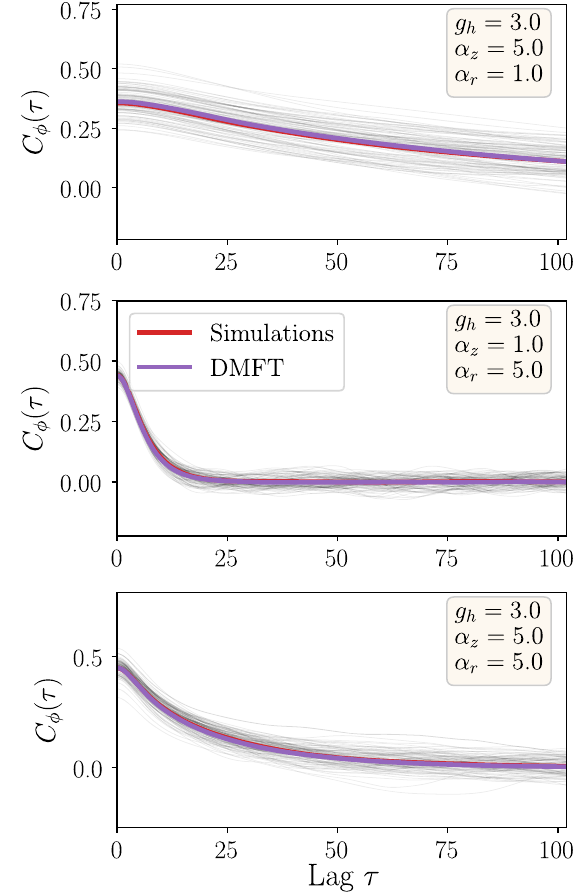
FIG. 9. Validating the DMFT. We show the comparison between the population-averaged correlation functions C ϕ ð τ Þ ≡ h ϕ ð t Þ ϕ ð t þ τ Þi obtained from the full network simulations of a single instantiation in steady state (purple line) and from solving the DMFT equations (red line) for three distinct parameter values. The lag τ is relative to τ (taken to be unity). Thin black lines are h the time-averaged correlation functions for individual neurons sampled from the network, to show the scale of fluctuations around the population-averaged correlation functions. N ¼ 5000 for all the panels.